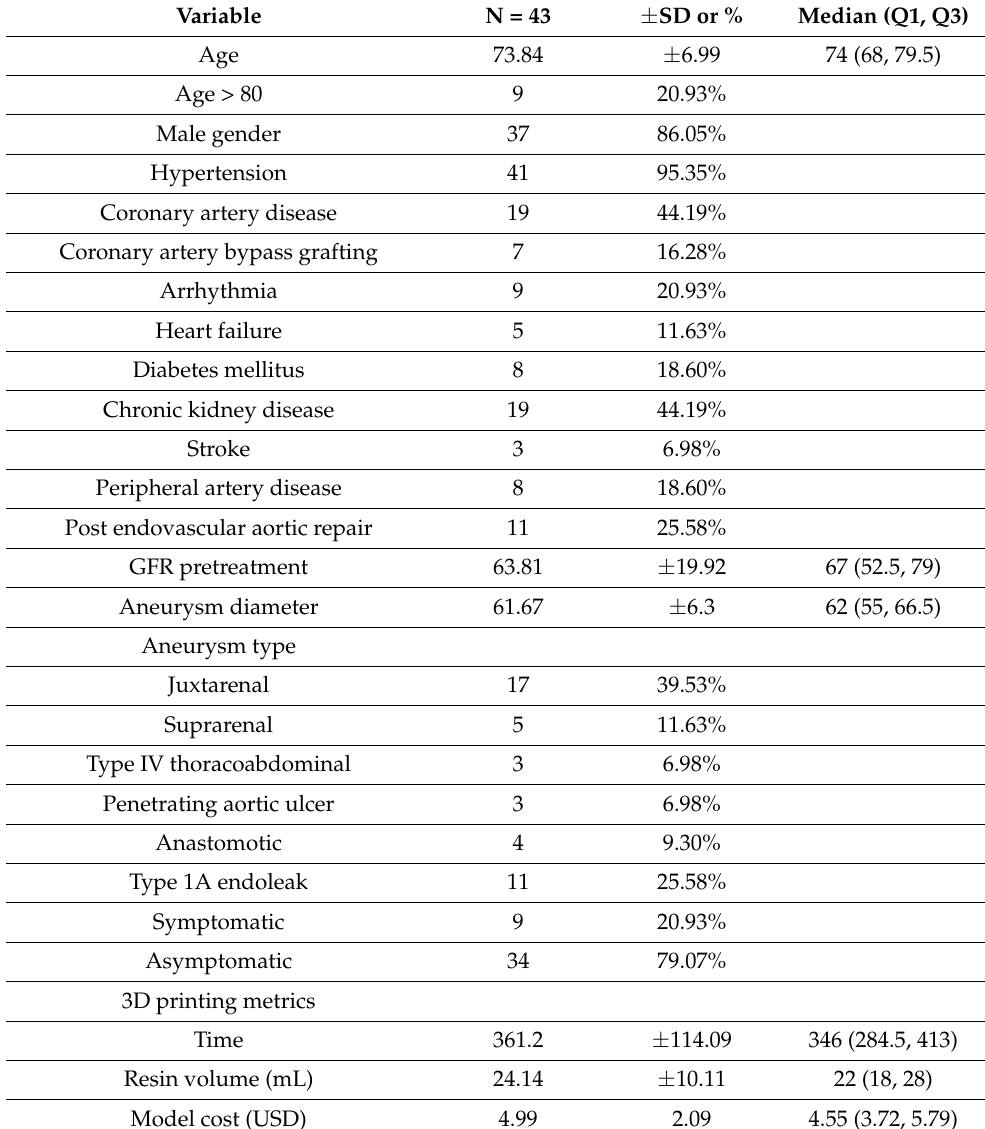
Table 1. Clinical and demographic patient characteristics and clinical outcomes.